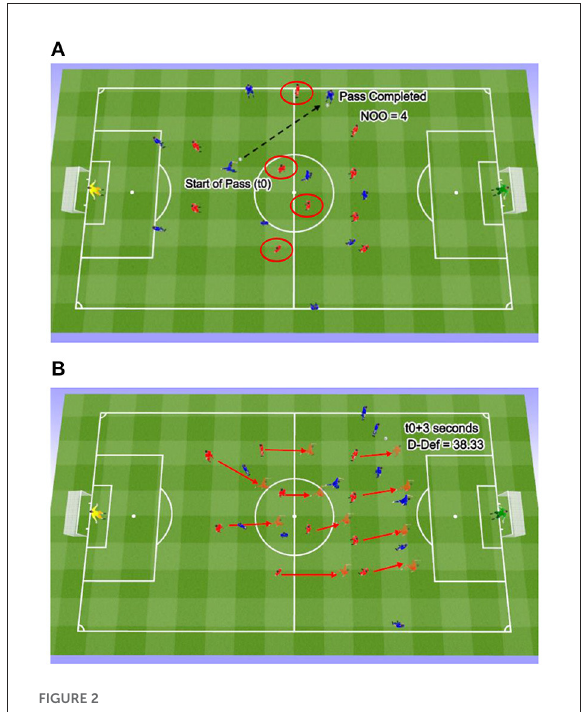
FIGURE2 A 2-dimensional representation of how D-Def and NOO were determined by a pass. The blue team is attacking toward the right against the defensive team in red. In (A) from the start of the pass (t0) to the time of pass completion, 4 defensive players (circled in red) were eliminated in the longitudinal direction. In (B) the red arrows represent the displacement of the defense from t0 to t + 3s, yielding a D-Def score of 38.33.